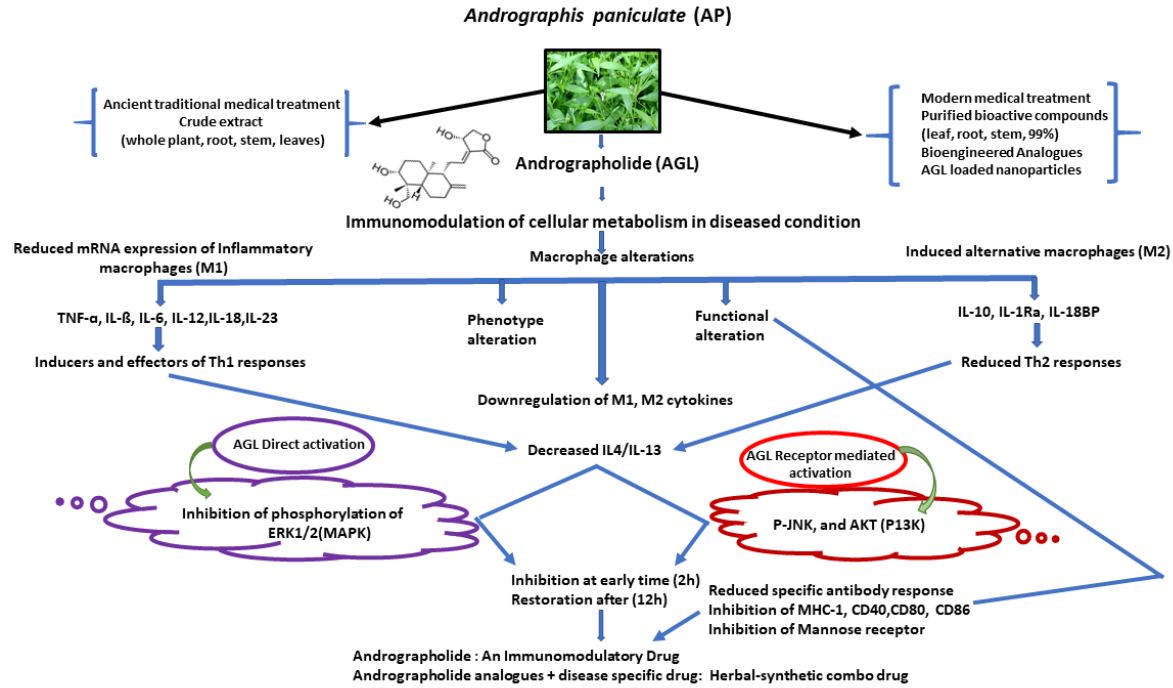
Figure 2. Schematic representation of the effects of andrographolide (AGL) and possible mechanism of its immunomodulatory regulation. Abbreviations: IL, interleukine; Th,T-helper cell type; MHS-1, major histocompatibility complex class II; CD, cluster of differentiation 80; CD86 cluster of differentiation; CD40, cluster of differentiation.